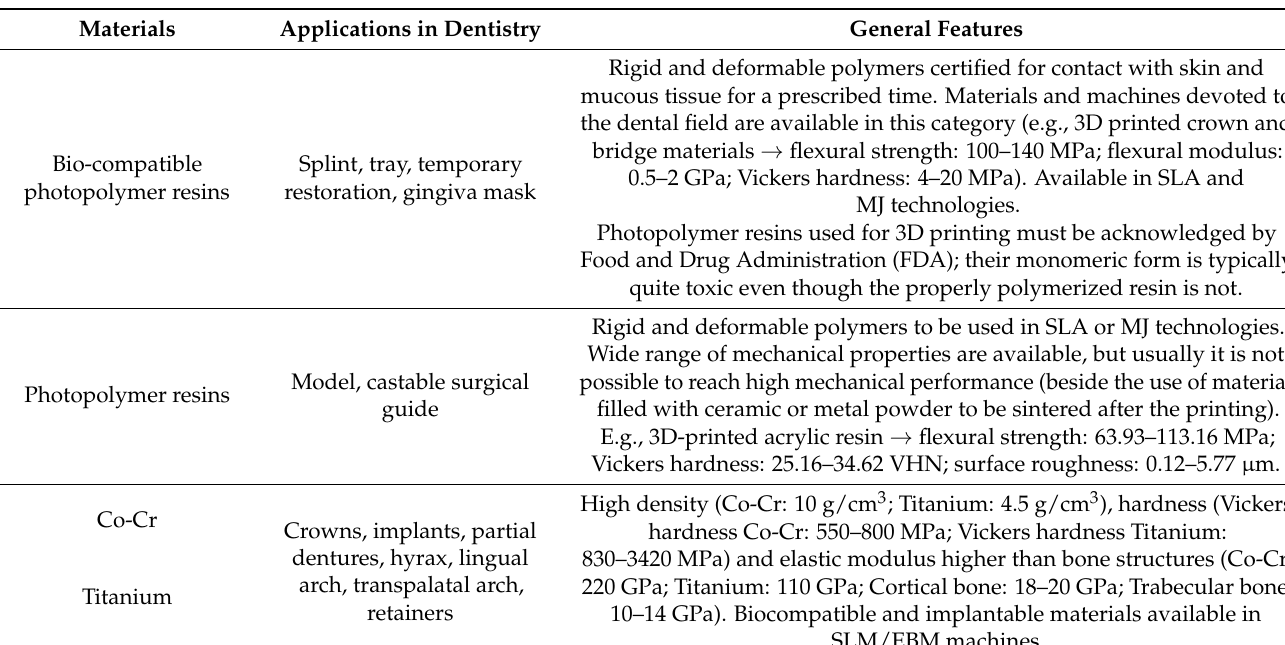
Table 1. Groups of materials printable with the different 3D-printing technologies, their applications in dentistry, and major